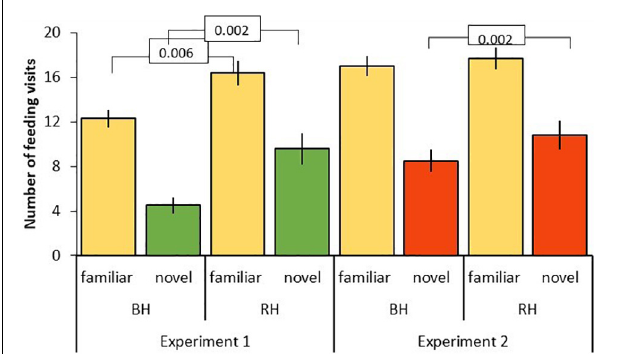
FIGURE 6 | Effect of partner head color on the number of feeding visits after first feed (mean = SE) to familiar and novel food for red-headed (RH) and black-headed (BH) Gouldian finches. Numbers in the figure represent p -values; black bars = black-headed pairs, hatched bars = mixed head color pairs, red bars = red-headed